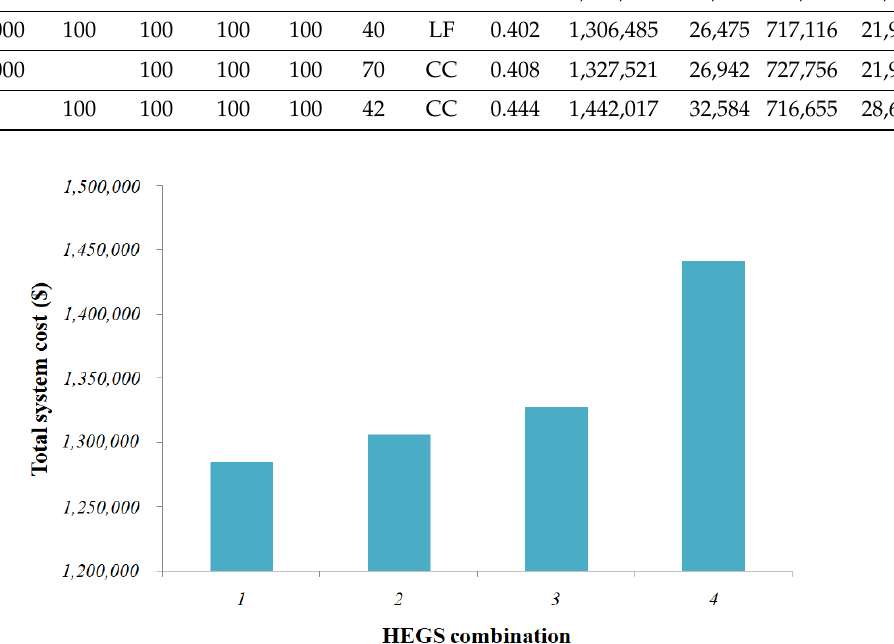
Figure 12. Comparison of total system cost for selected HEGS combination.